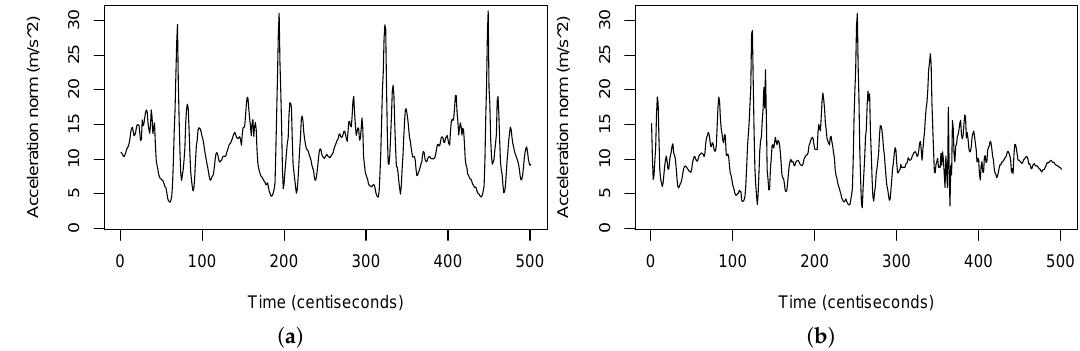
Figure 1. Norm of the acceleration experienced by a mobile phone when its owner is walking ( a ), and not walking, but gesticulating with the mobile in his/her hand ( b